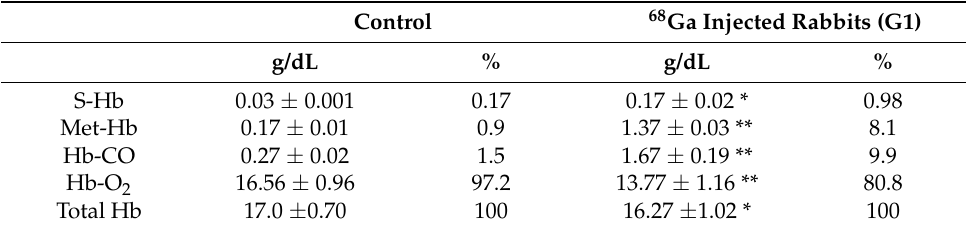
Table 1. Hemoglobin derivative concentrations of rabbits injected with 2 MBq/kg Gallium-68 (G1) as compared with the control group (mean ± SE).